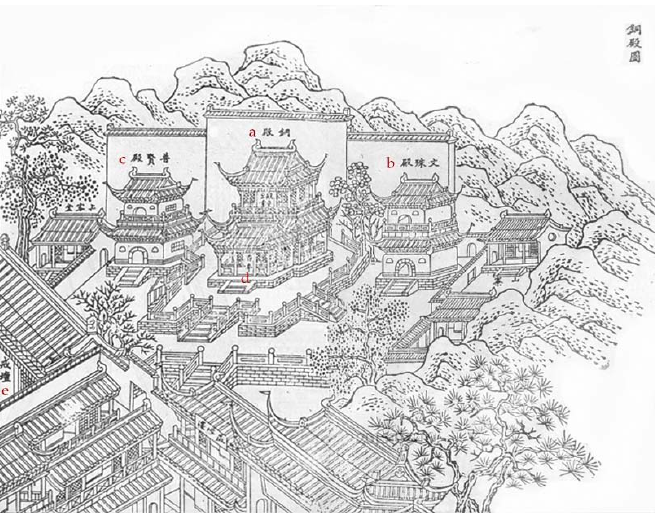
Figure 2. A detailed image of the copper hall and Beamless Halls of Longchang Monastery: ( a ) Copper Hall; ( b ) Wenshu Hall; ( c ) Puxian; ( d ) Incense Pavilion; ( e ) Ordination Platform Unit. (BHSZ [1795] 1975, vols. 1, 5).